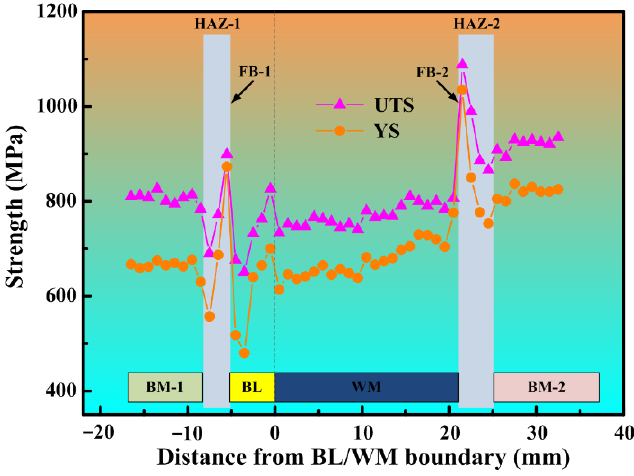
Figure 15. Strength along the DMWJ